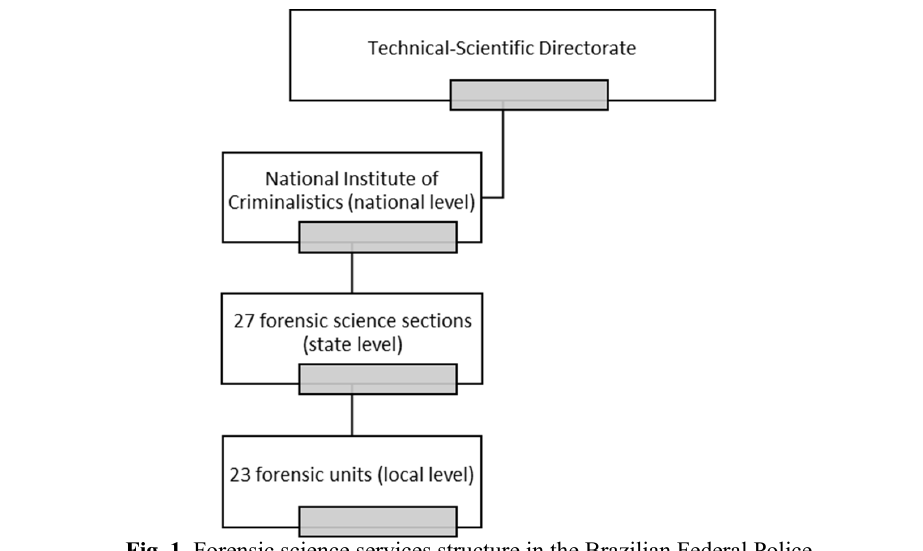
Fig. 1 . Forensic science services structure in the Brazilian Federal Police